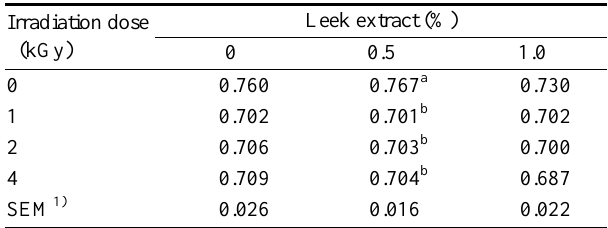
Table 1. Water activity (Aw) of the electron beam irradiated pork jerky with added leek extract Irradiation